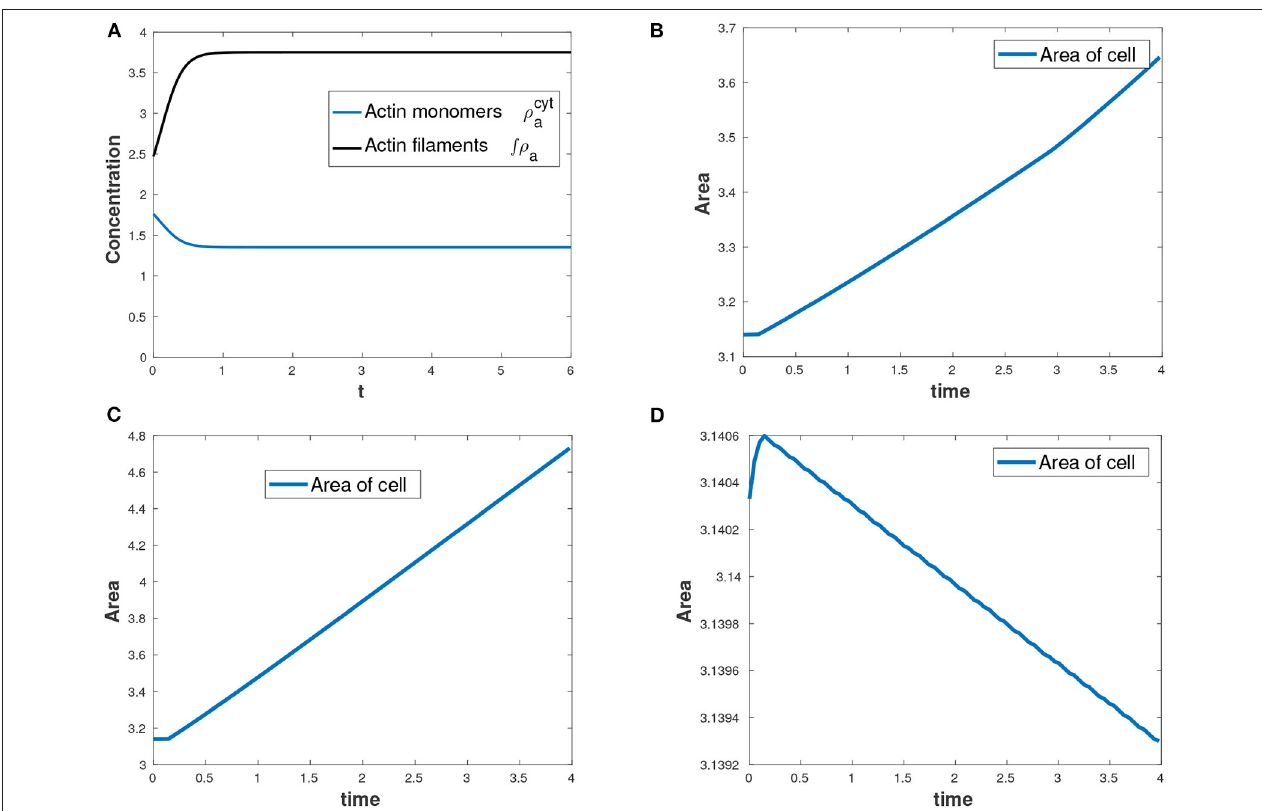
FIGURE 4 | (A) Conservation of mass for actin with total amount of actin as ρ tot a = 10, (B) area of the growing cell as a function of time for the case ρ tot a = 10 as shown in Table 2 , (C) area of the cell with an increased total amount of actin ρ tot a = 16 while all other parameters in Table 2 held constant and (D) decreasing area of the cell with a reduced total amount of actin ρ tot a = 5 while all other parameters in Table 2 held constant.